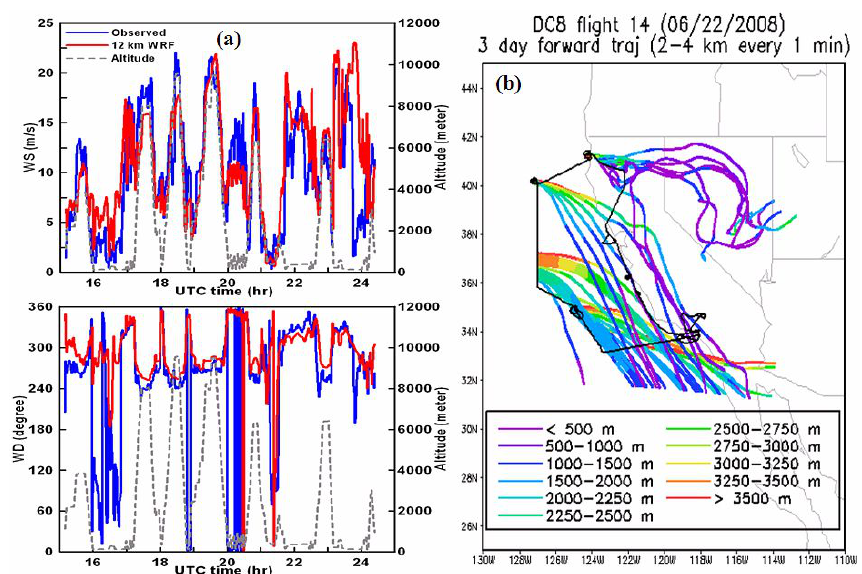
Fig. 14. (a) Observed and 12km WRF-modeled wind fields along the 22 June DC-8 flight path; (b) forward trajectories originating at 2–4km of the oceanic part of the same